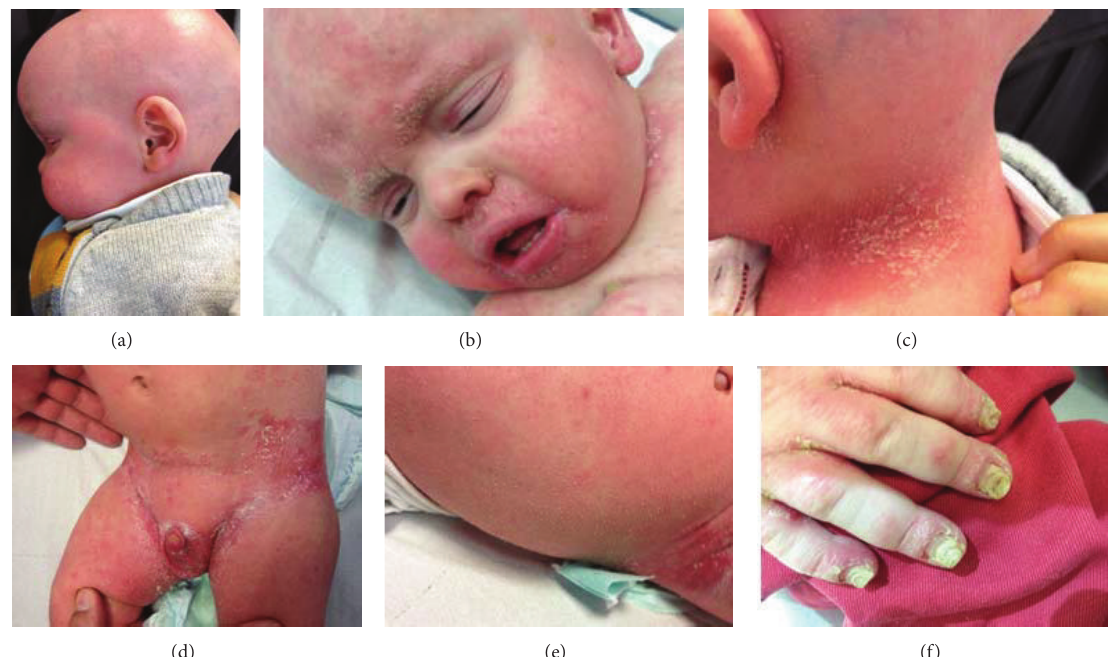
Figure 1: Clinical appearance and dermatologic findings of the patient. Note the alopecia with an absence of scalp hair, eyebrows, and lashes (a). Spiky follicular hyperkeratosis on the trunk. Skin was dry and scaly and erythematous follicular papules were observed over posterior aspect of the neck and groin ((c), (d), and (e)), cheilitis (b), and dystrophic nails